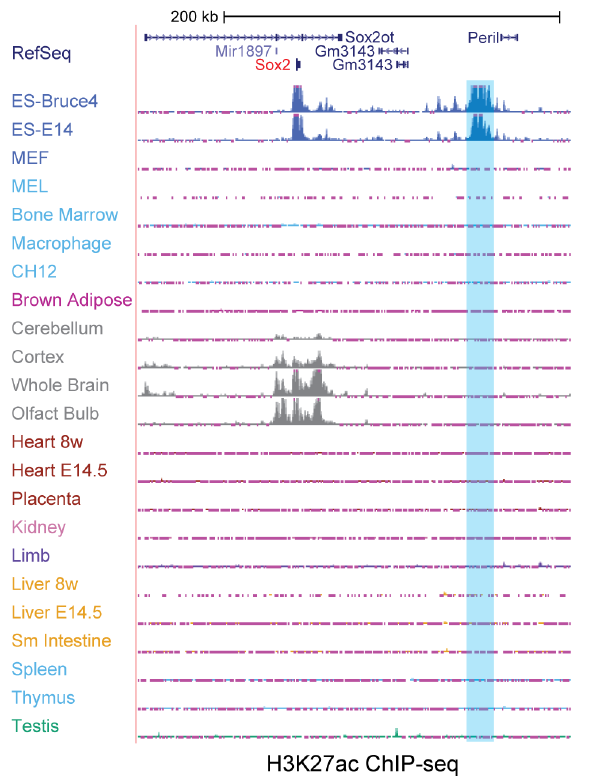
Figure 1. Identification of a distal mouse ESC-specific super-enhancer near Sox2 gene. In a genome- browser snapshot, 23 tracks of H3K27ac ChIP-seq data are shown. The top 2 tracks are from two different mouse ESC lines. Shadowed region shows the location of the mEnh-Sox2 distal